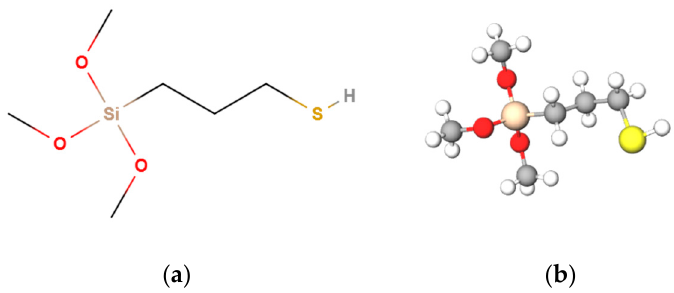
Figure 4. 2D ( a ) and 3D ( b ) chemical structure of PropS-SH (3-mercapto-propyl-trimethoxysilane).